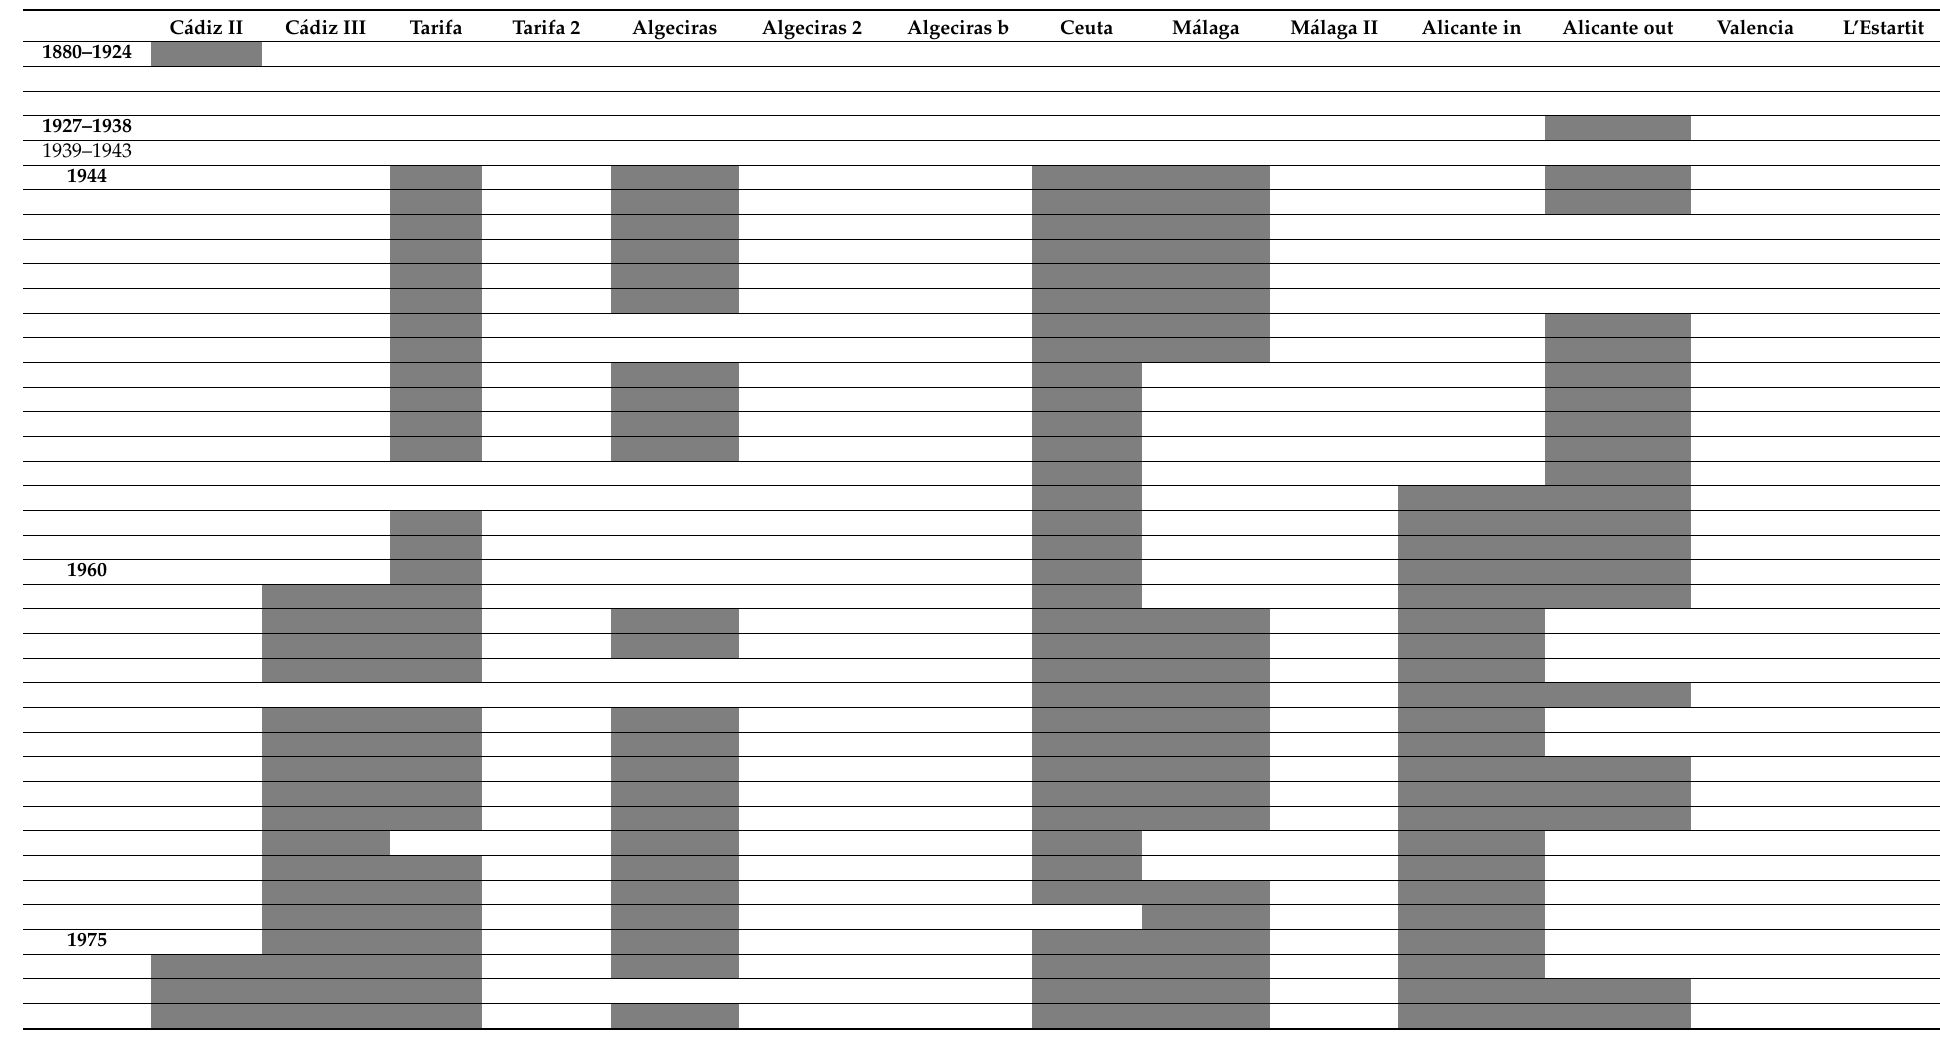
Table 1. In bold, tide gauge stations with long time series used for the analysis of inter-annual and long-term variability. In normal font are the names of those time series used for filling the gaps in the long time series. Shaded squares correspond to those years with fewer than three missing monthly values. The interruption in the years is due to the lack of data from 1939 to